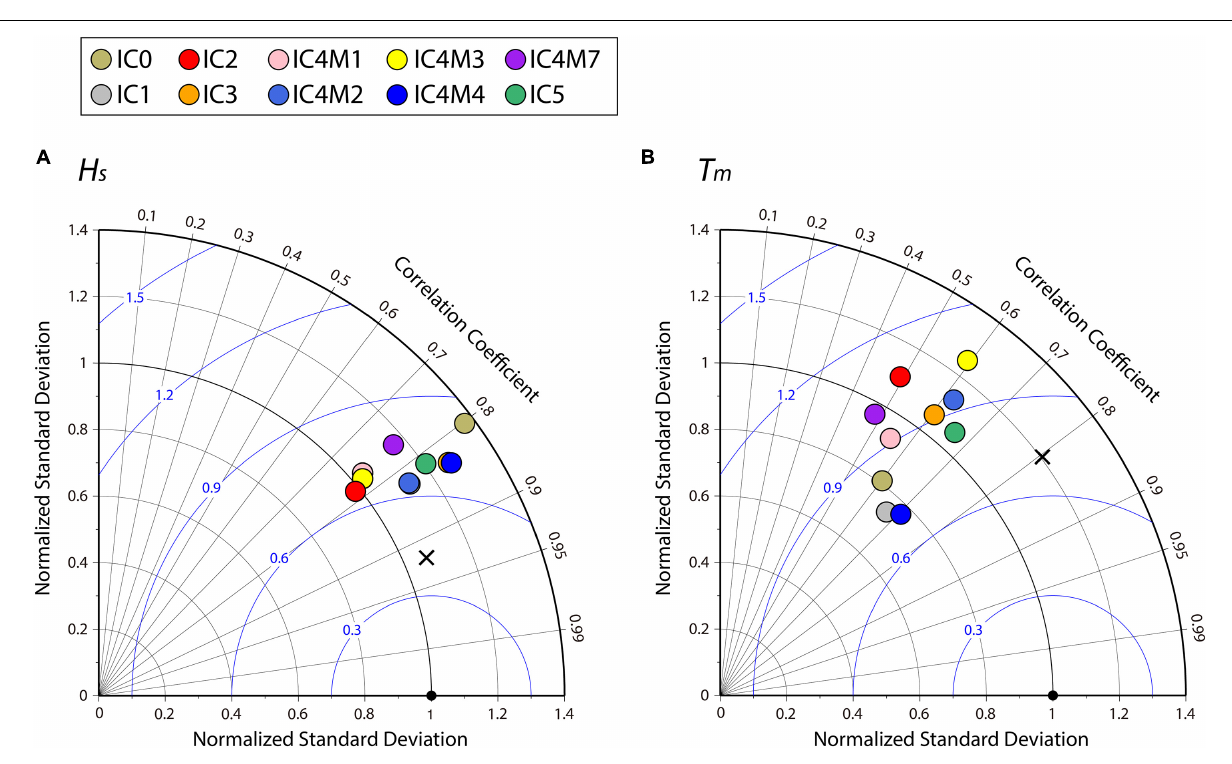
FIGURE 4 | Taylor diagram summarizing the statistical comparison between the NOWPHAS buoy observation and the model simulations with ST6 for the ice-covered condition: (A) H s and (B) T m . The number of validation data points is 3277. The source terms of S ice are represented by the different colored circles (legend in the upper region of the panel). The black cross shows the modeled results of IC1 simulation for the open water condition (i.e., results of Figure 3 ). The black circle at the bottom indicates the buoy observation. The blue colored contour with an interval of 0.3 denotes the RMSE between the simulations and observations. The RMSE and standard deviations have been normalized by the observed standard deviation. The correlation coefficients between both the fields are shown by the azimuthal position of the simulation field. Note that the position of IC1 (gray circle) overlaps that of IC4M2 (light blue circle) in the left